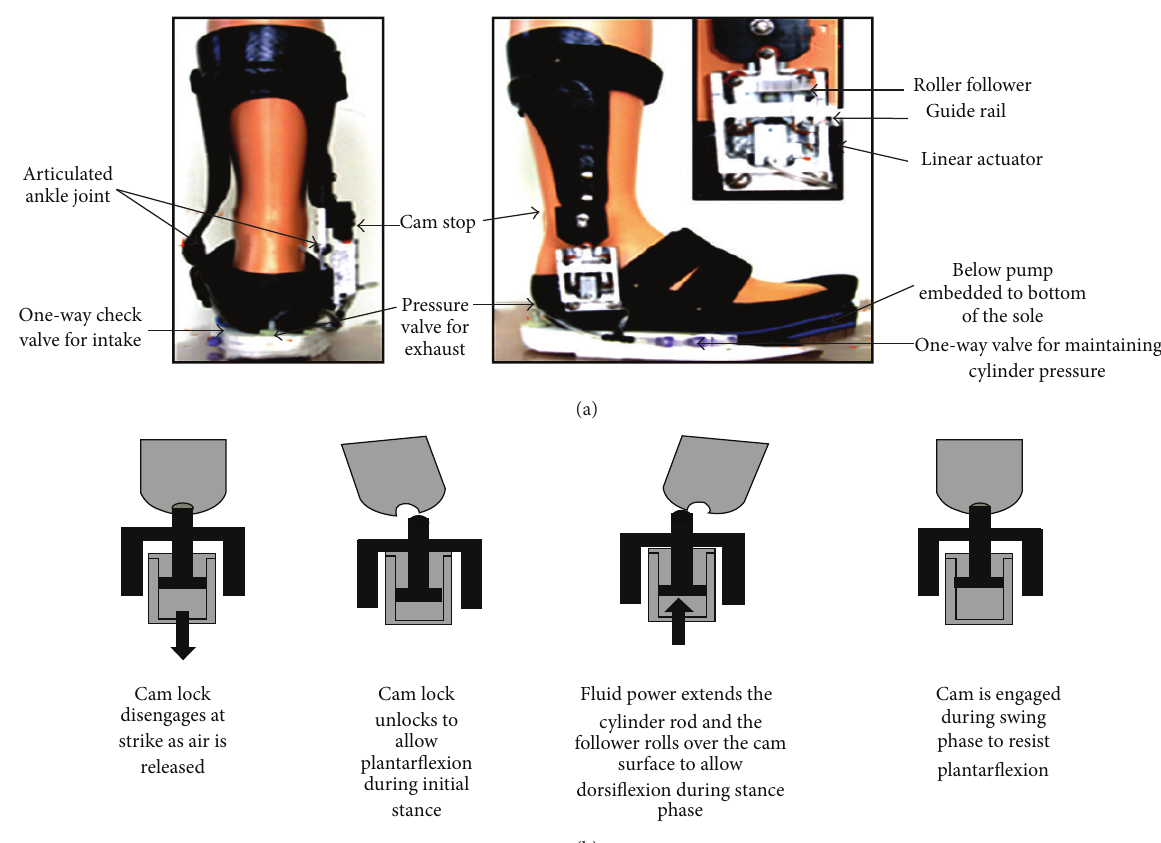
Figure 4: (a) Posterior and lateral view of a power harvesting AFO (b) engaging and disengaging of cam lock during gait cycle [10].